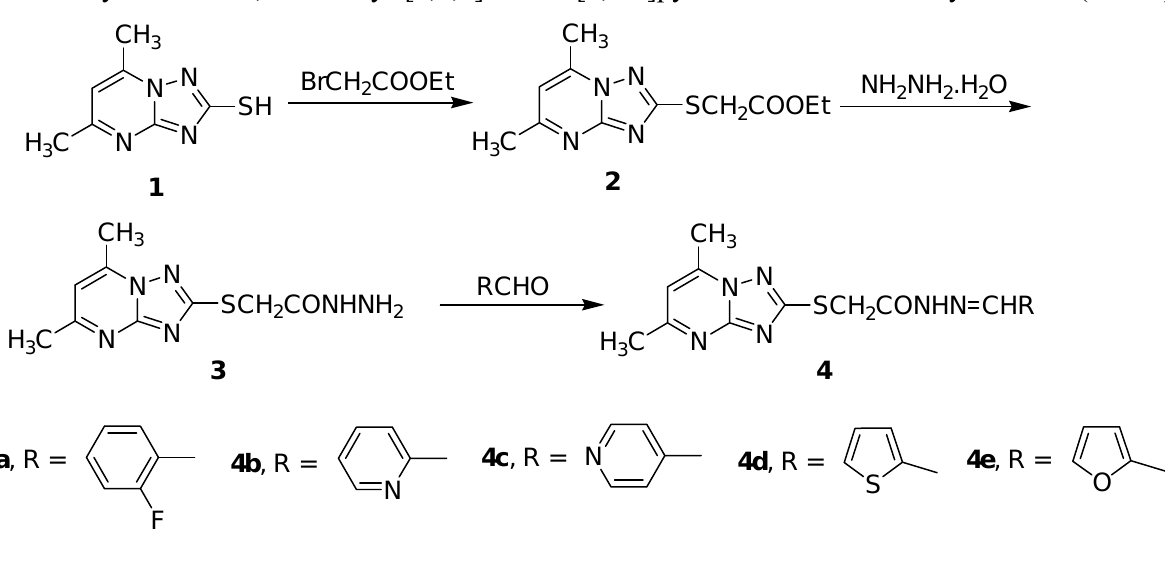
Figure 1. UV absorption spectra of 4a in (1) the solid state and (2) DMF (1×10 -5